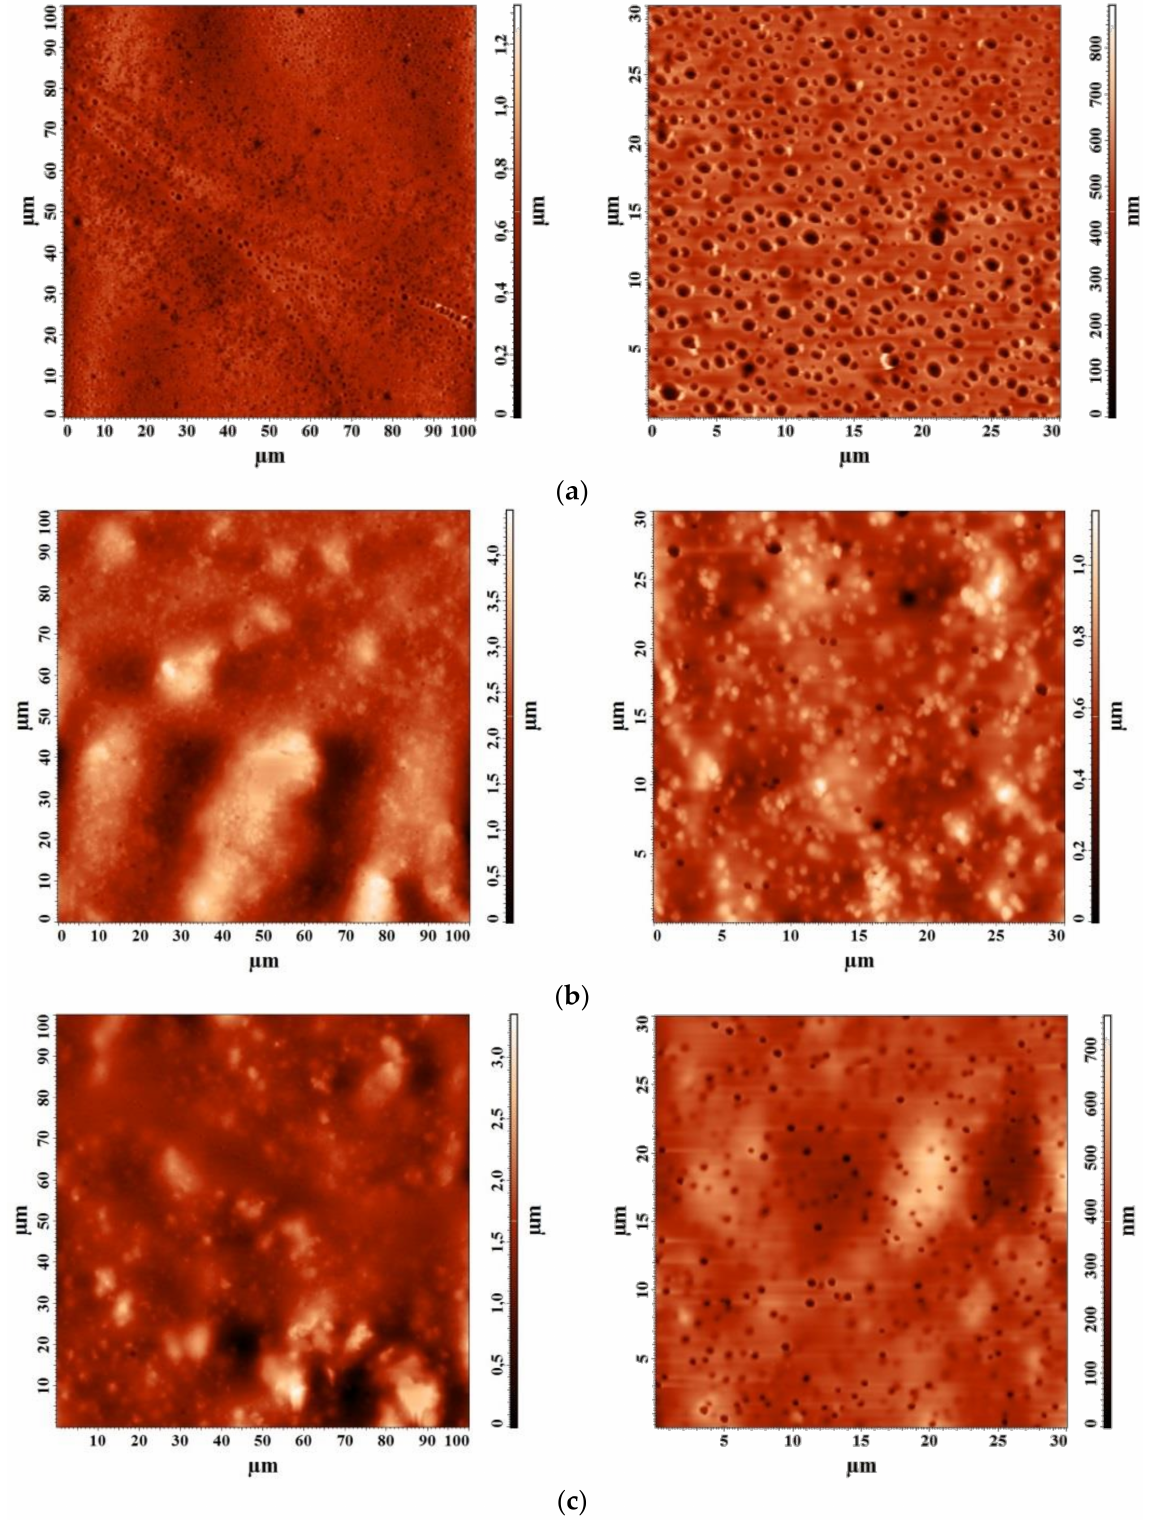
Figure 16. AFM images with a scanning scale of 100 × 100 and 30 × 30 µ m for nanofiltration- supported ( a ) PIM-1, ( b ) PIM-1/MIL-125, and ( c ) PIM-1/MIL-140A